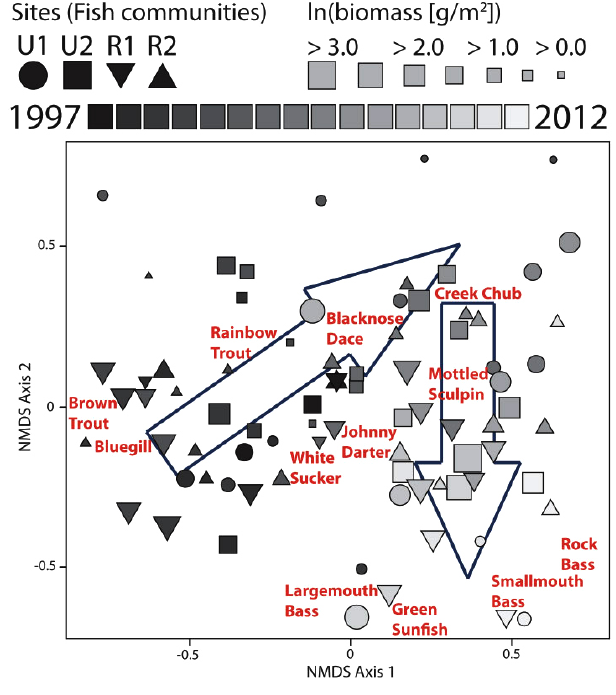
Fig. 4 . Nonmetric multidimensional scaling (NMDS) plot of fish communities at four Juday Creek sites (unrestored: U1 is shown as circles, U2 is shown as squares; restored: R1 is shown as downward pointing triangles, R2 is shown as upward pointing triangles) from 1997 through 2012. Larger shapes represent higher biomass than smaller shapes. Shading shows communities over time from dark (1997) to light (2012). Fish communities that are similar in species compositions appear closer in ordination space than those fish communities that differ in species compositions. For example, the fish communities of R1 and R2 were similar to one another in 1998 and 1999, when brown trout were a large proportion of the fish community by abundance. In 2012, the fish communities of R1 and R2 were also similar but with higher proportional abundances of smallmouth bass and rock bass. This change is illustrated by a shift of R1 and R2 symbols from the left side of the plot (1998/99) to the right side (2012). Arrows emphasize community shift over